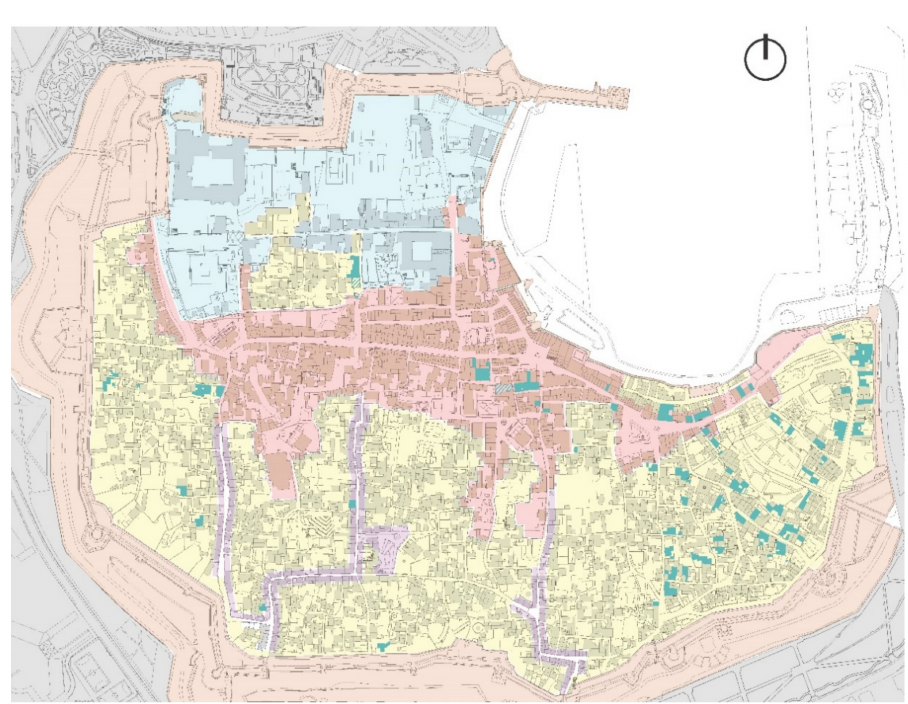
Figure 6. Zones of existing the land uses of the Medieval